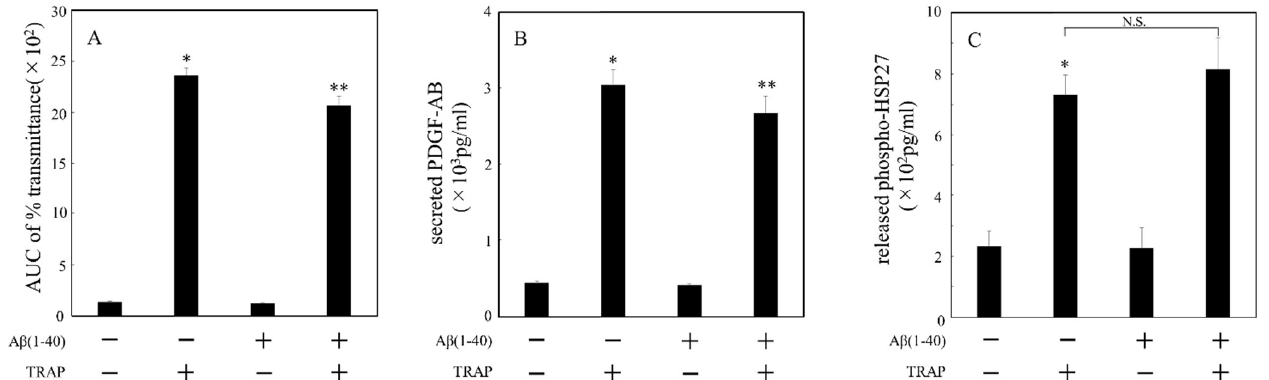
Figure 3. Effects of A β (1–40) on the TRAP-induced secretion of PDGF-AB and release of phospho- rylated HSP27 from human platelets of DM patients. PRP was pretreated with 10 µ M of A β (1–40) or vehicle at 37 ◦ C for 15min and then stimulated with 8–15 µ M of TRAP or vehicle for 5 min. The dose of TRAP achieving a transmittance of 70–100% recorded using a PA-200 aggregometer was adjusted individually. The reaction was terminated by the addition of an ice-cold EDTA solution. Platelet aggregation determined by PA-200 aggregometer and presented as AUC of % transmittance ( A ). The mixture was centrifuged at 10,000 × g at 4 ◦ C for 2 min, and the supernatant was subjected to ELISA for PDGF-AB ( B ) and phosphorylated HSP27 ( C ). The results obtained from 96 DM patients are shown. Each value represents the mean ± standard error of the mean. * p < 0.05, compared to the value of control. ** p < 0.05, compared to the value of agonist alone. N.S. indicates not